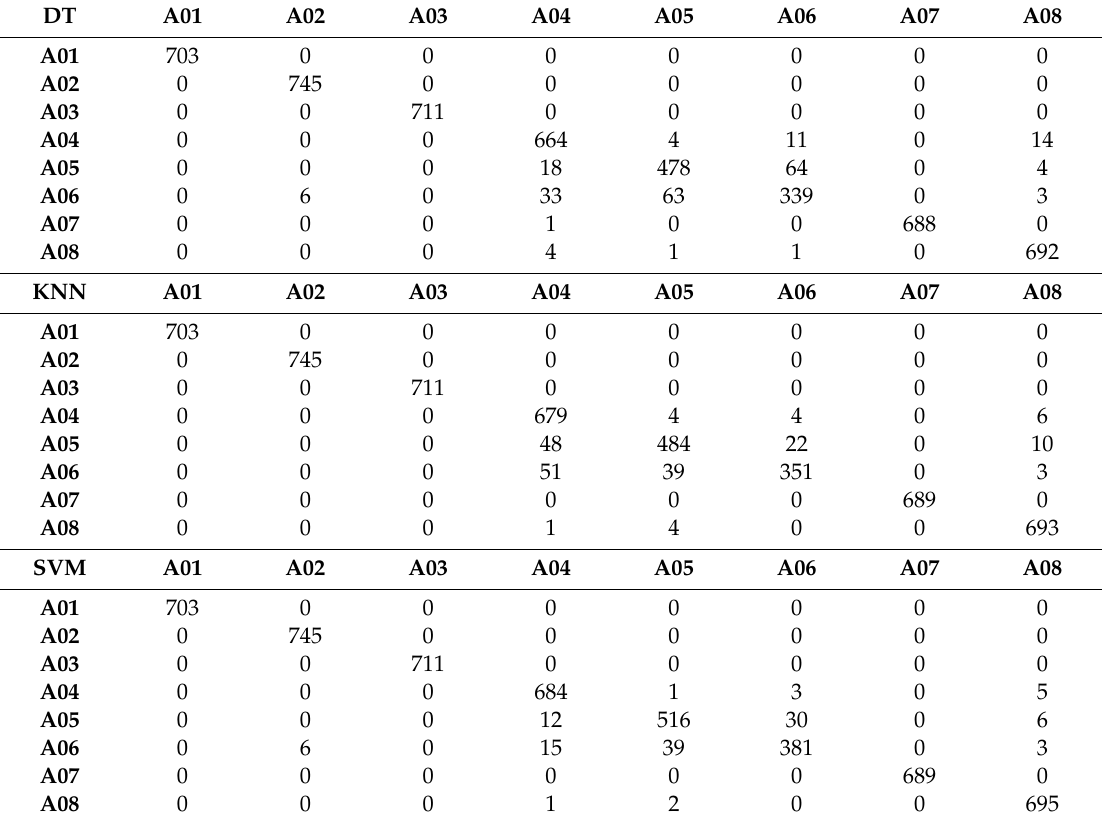
Table 5. Recognition results comparison between three